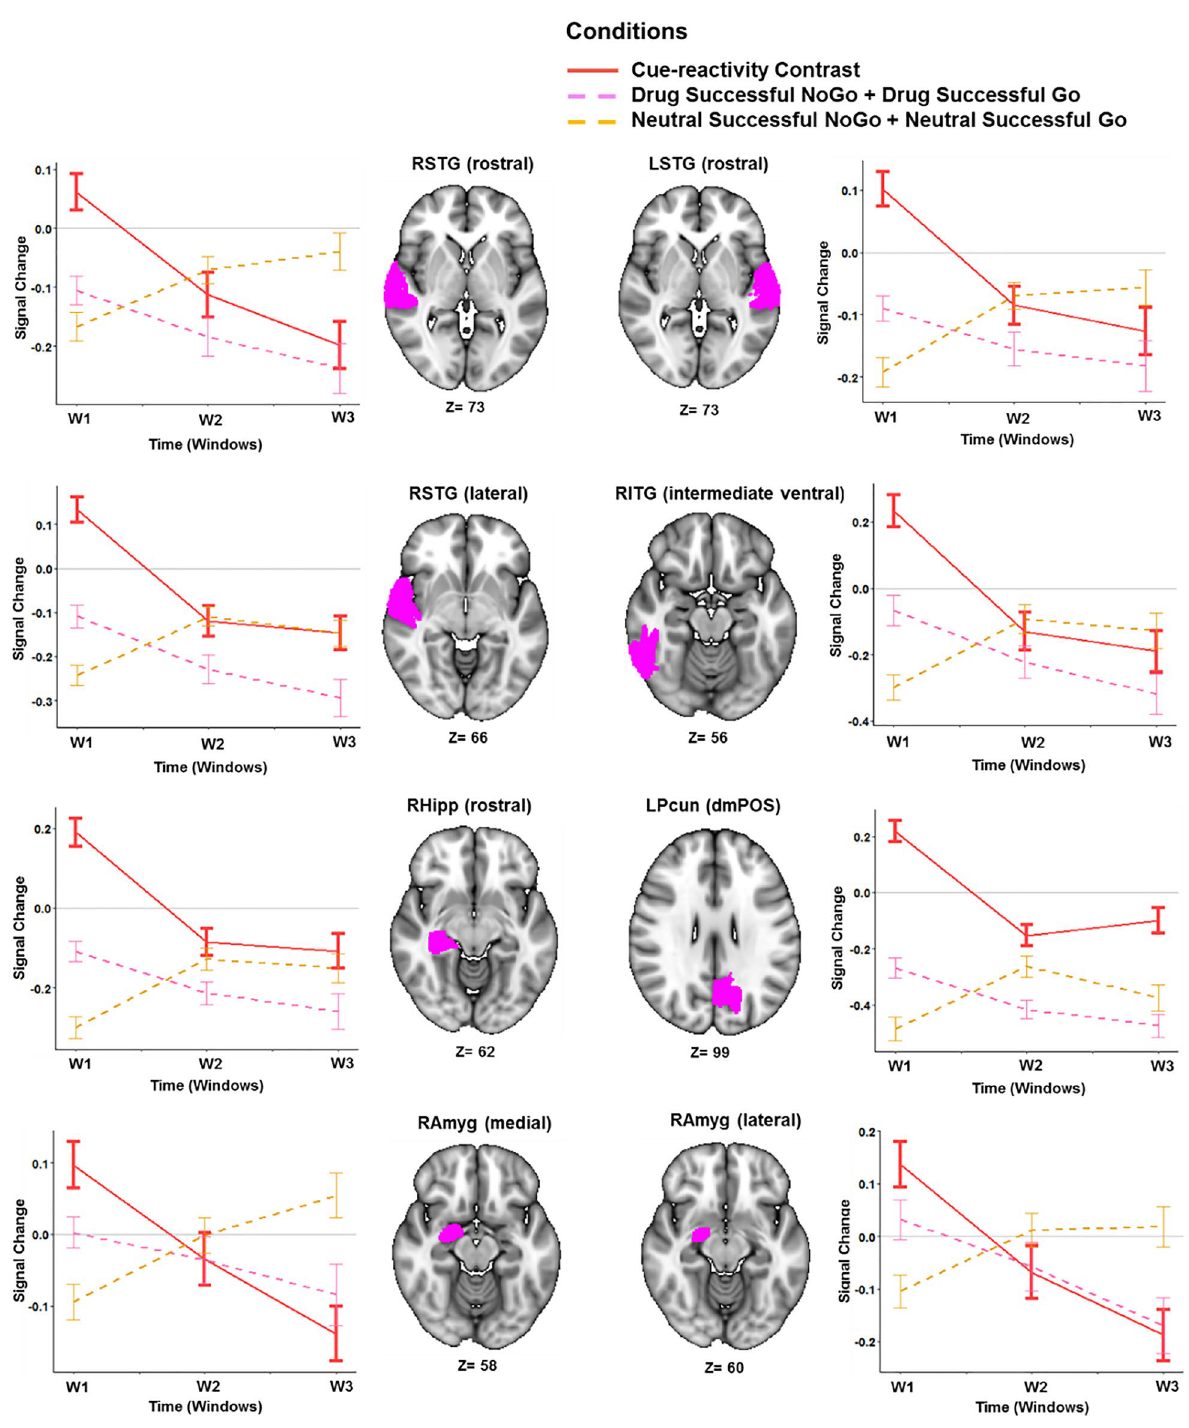
Figure 3. Temporal behavior of ROIs with significant condition by time interactions in the cue-reactivity linear mixed effects (LME) model. Lines show the average main effect of Drug (Drug Successful NoGo + Drug Successful Go) or Neutral (Neutral Successful NoGo + Neutral Successful Go) cue-exposure condition in the Brainnetome (BNA) regions or the result of Drug vs. Neutral contrast, and error bars show the standard error of z-statistic values across 53 methamphetamine use disorders (MUD) at each temporal window (FDR corrected p- value < 0.001). The graphs were implemented and visualized using R software version 3.6.2 (https:// www.r- proje ct. org/). 3D brains were visualized using FSLeyes, the FSL image viewer (https:// open. win. ox. ac. uk/ pages/ fsl/ fsley es/ fsley es/ userd oc/ insta ll. html). RSTG right superior temporal gyrus, LSTG left superior temporal gyrus, RITG right inferior temporal gyrus, RHipp right hippocampus, LPcun left precuneus, RAmyg right